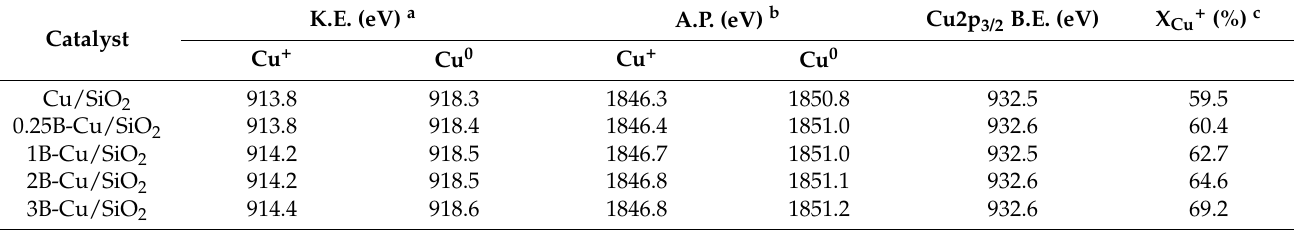
Table 3. Surface Cu component of reduced catalysts based on Cu LMM